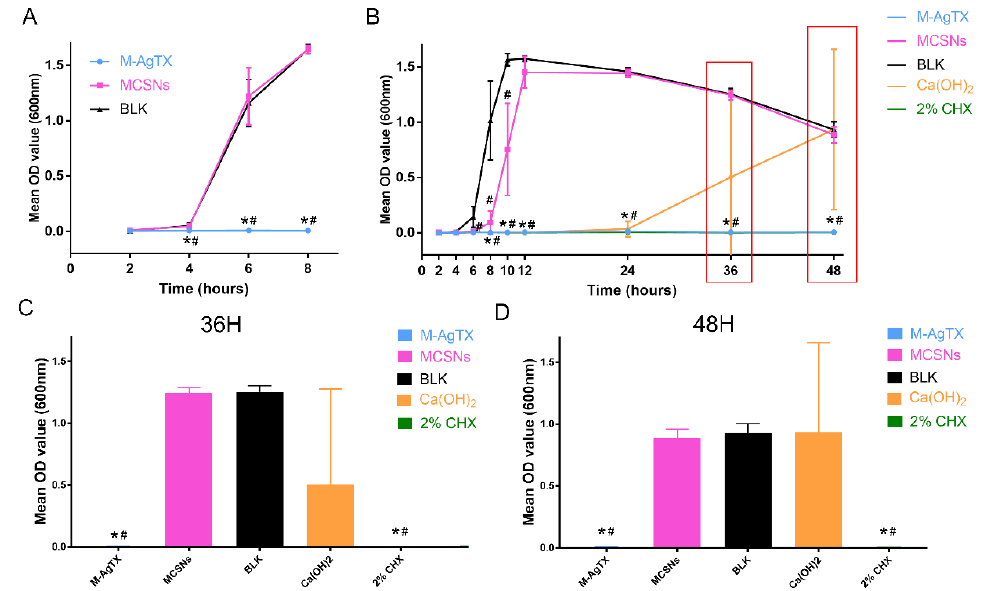
Figure 9. The OD value after the direct soaking of dentin slices from different treatments in fresh BHI media. ( A ) Pretreated dentin slices; ( B ) Dentin slices with 4-week E. faecalis biofilm after 7-day medication; ( C , D ) Comparisons of OD value at 600 nm at 36 h and 48 h of ( B ). (*,#: significant difference when compared with MSCNs group and BLK group, respectively, p < 0.05.) .